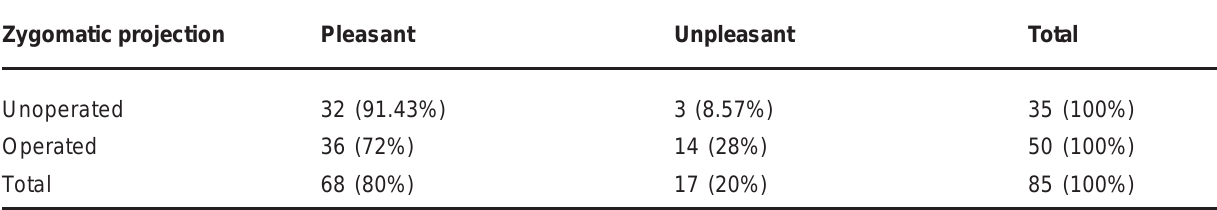
TABLE 4- Statistics of evaluation of the facial pattern